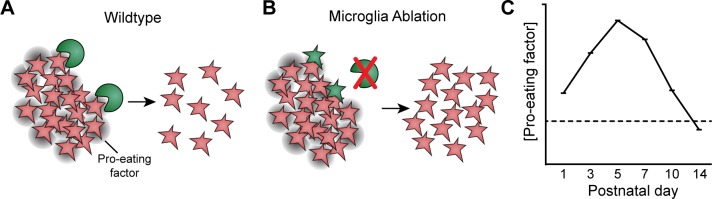
Model of the mechanisms driving developmental astrocyte death.Schematic illustrating the proposed mechanism of developmental astrocyte death, based on findings of this study. In wild-type mice (A), microglia (green) sense the number of astrocytes (red) within their local environment, perhaps due to expression of an astrocyte-derived pro-eating factor (gray shading; right panel). When astrocyte numbers are high, microglia are stimulated to remove them via phagocytosis. As astrocyte number falls, the amount of astrocyte-derived cue eventually becomes insufficient to stimulate microglia, thereby closing the death period (C). When microglia are ablated (B), death is temporarily halted. But astrocytes (green) eventually sense their own elevated numbers (red), leading them to phagocytose each other.